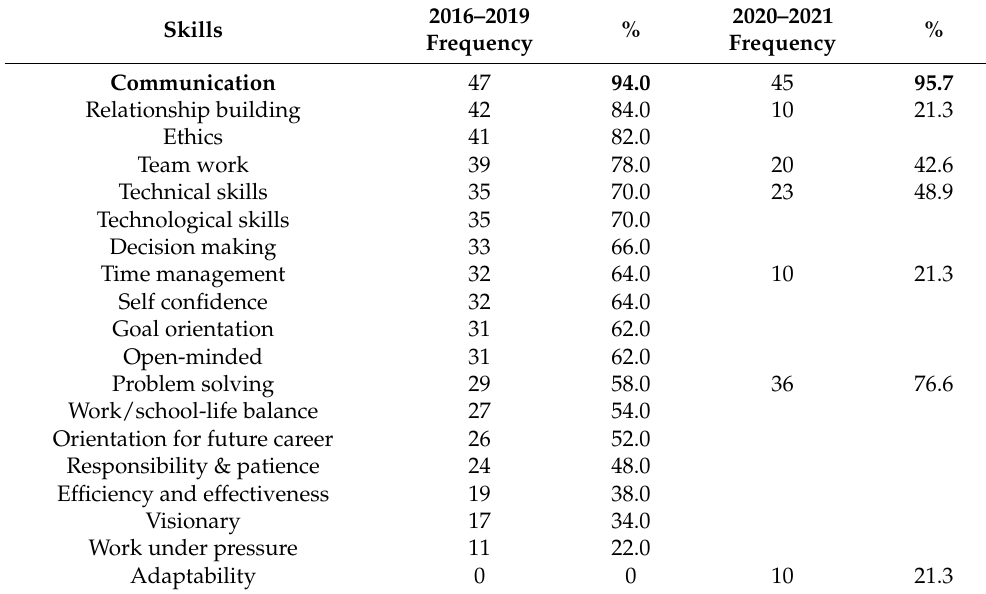
Table 3. Skills acquired/enhanced from